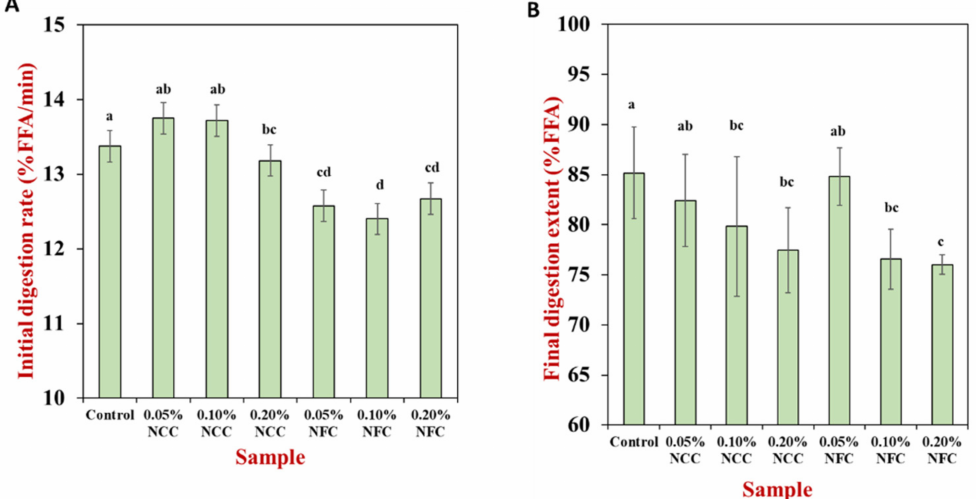
Figure 8. Initial digestion rate ( A )and final digestion extent ( B ) of 10% ( w / w ) O/W emulsions containing β -carotene stabilized by either nanocrystalline cellulose (NCC) or nanofibrillated cellulose (NFC) at various concentrations. Samples designated with different lowercase letters (a − d) were significantly different (Duncan, p <